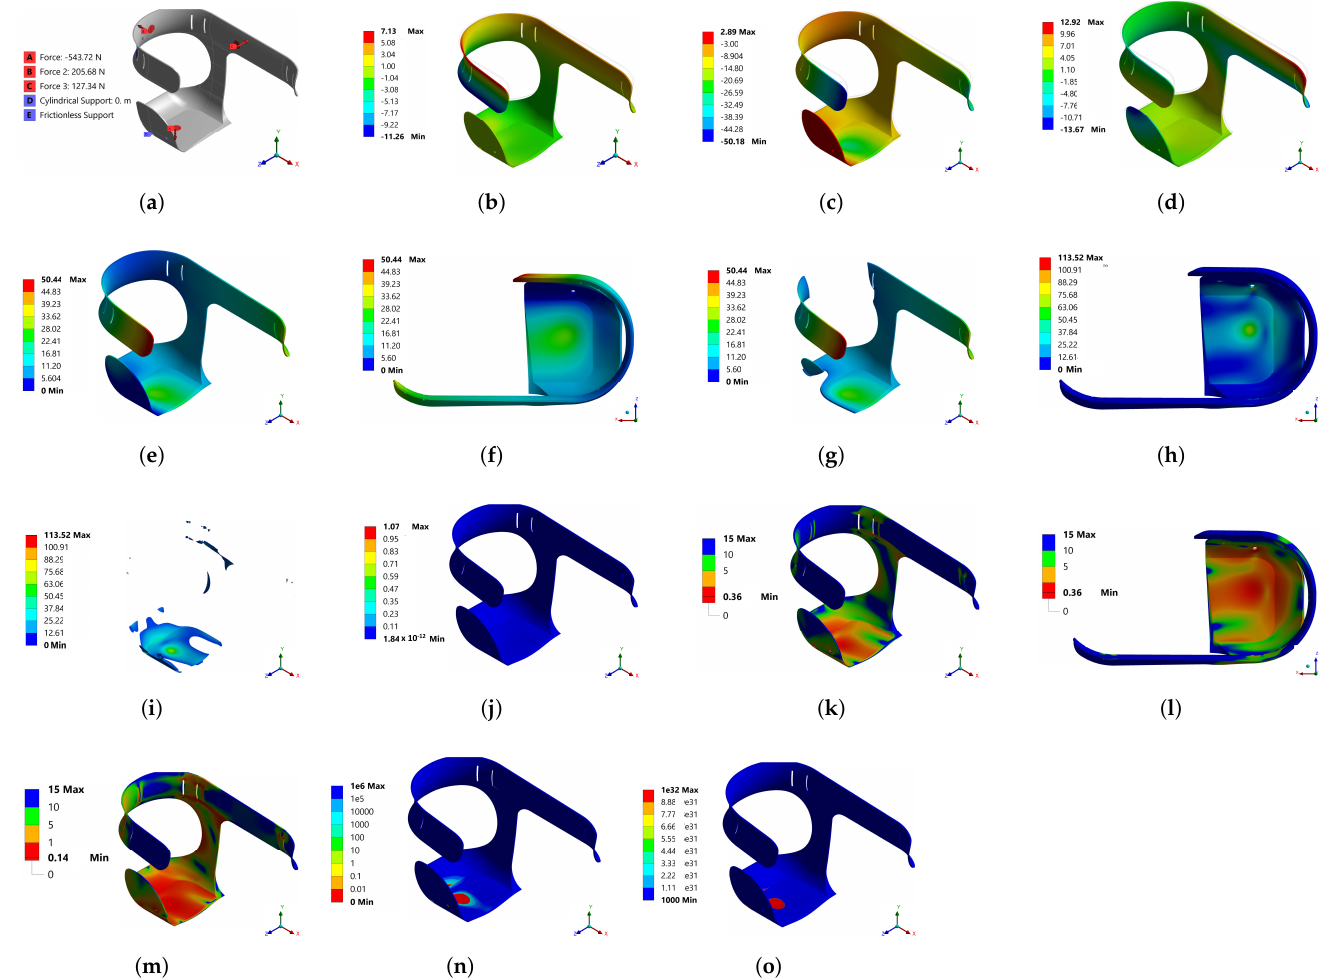
Figure 6. Mechanical behavior results for Model 2: ( a ) loads and supports; ( b ) directional defor- mation (mm) (x-axis); ( c ) directional deformation (mm) (y-axis); ( d ) directional deformation (mm) (z-axis).; ( e ) total deformation (mm); ( f ) total deformation (mm), top view; ( g ) total deformation (mm), surfaces with greater deformation; ( h ) Von Mises equivalent stress (MPa) top view; ( i ) Von Mises equivalent stress (MPa), zones with stress greater than 50 MPa; ( j ) structural error (mJ); ( k ) safety factor, static load; ( l ) safety factor, static load top view; ( m ) fatigue, safety factor; ( n ) fatigue, life; ( o ) fatigue,